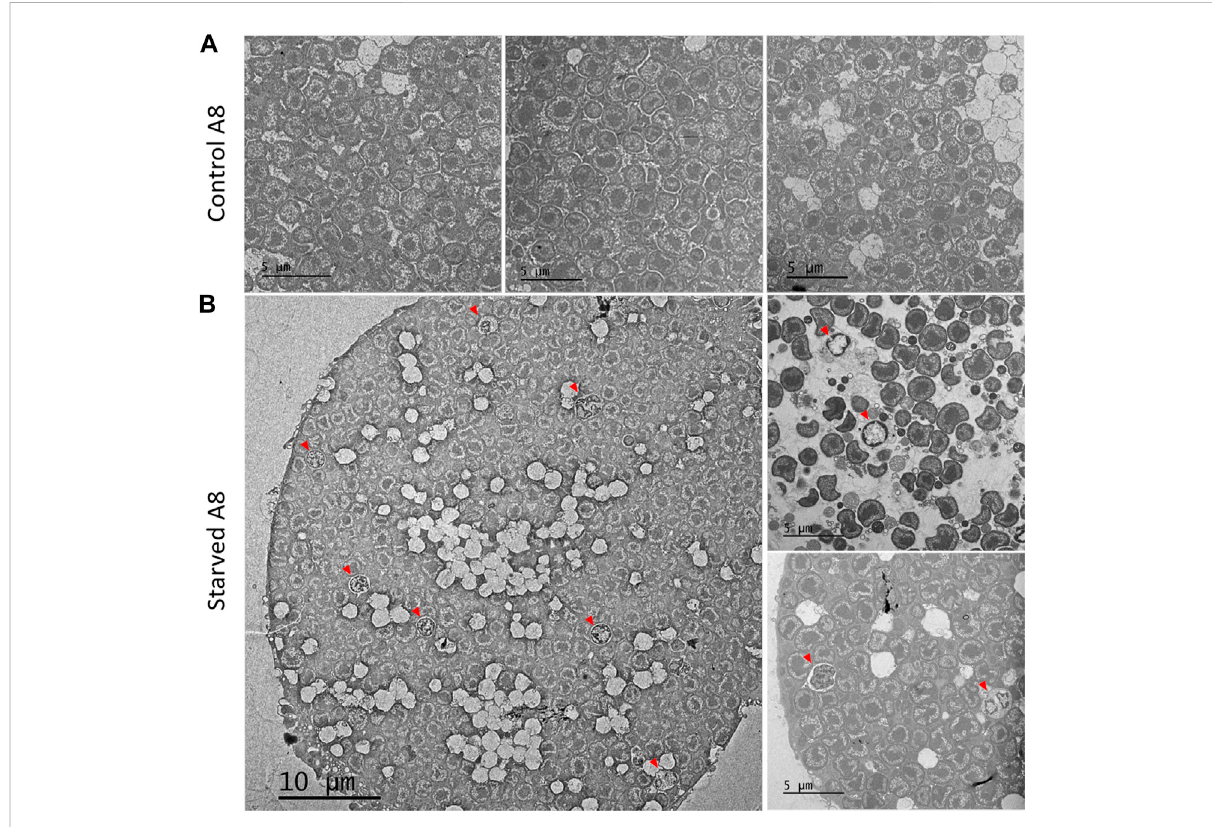
Effect ofstarvationon symbiont phenotype.TEMimageofrepresentativebacteriocytesfrom8-day-oldaphidsreared onplantfrombirth (A) or that were transferred back to plant after a 24 h starvation period (B) . Red arrowheads indicate lysosomal-like vacuoles containing